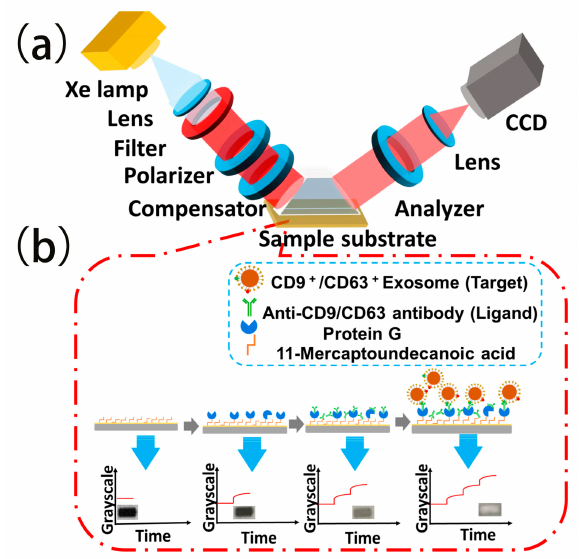
Scheme 1. TIRIE for the detection of exosomes: ( a ) Schematic of TIRIE with the typical conventional polarizer–compensator–sample–analyzer configuration; ( b ) schematic of the bioreaction process on the sensing surface and the sensing signals recorded by TIRIE, correspondingly. The grayscale image shows the intensity of the light which is characteristic of the surface mass density distribution of the biomolecular layers on the surface. When the ligand in the solution interacts with the target, a complex is assembled on the surface by affinity and the surface mass density is changed. With the visualization by TIRIE, the changes on the surface are be transformed into grayscale and the targets in the solution can be verified